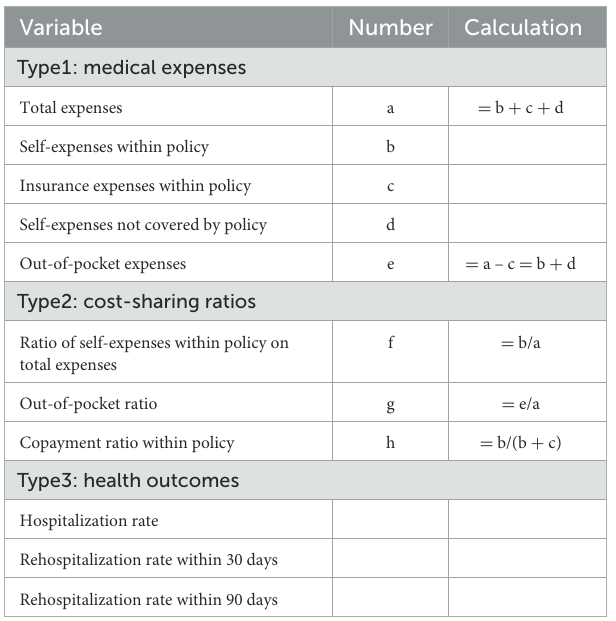
TABLE 2 Definition of outcome